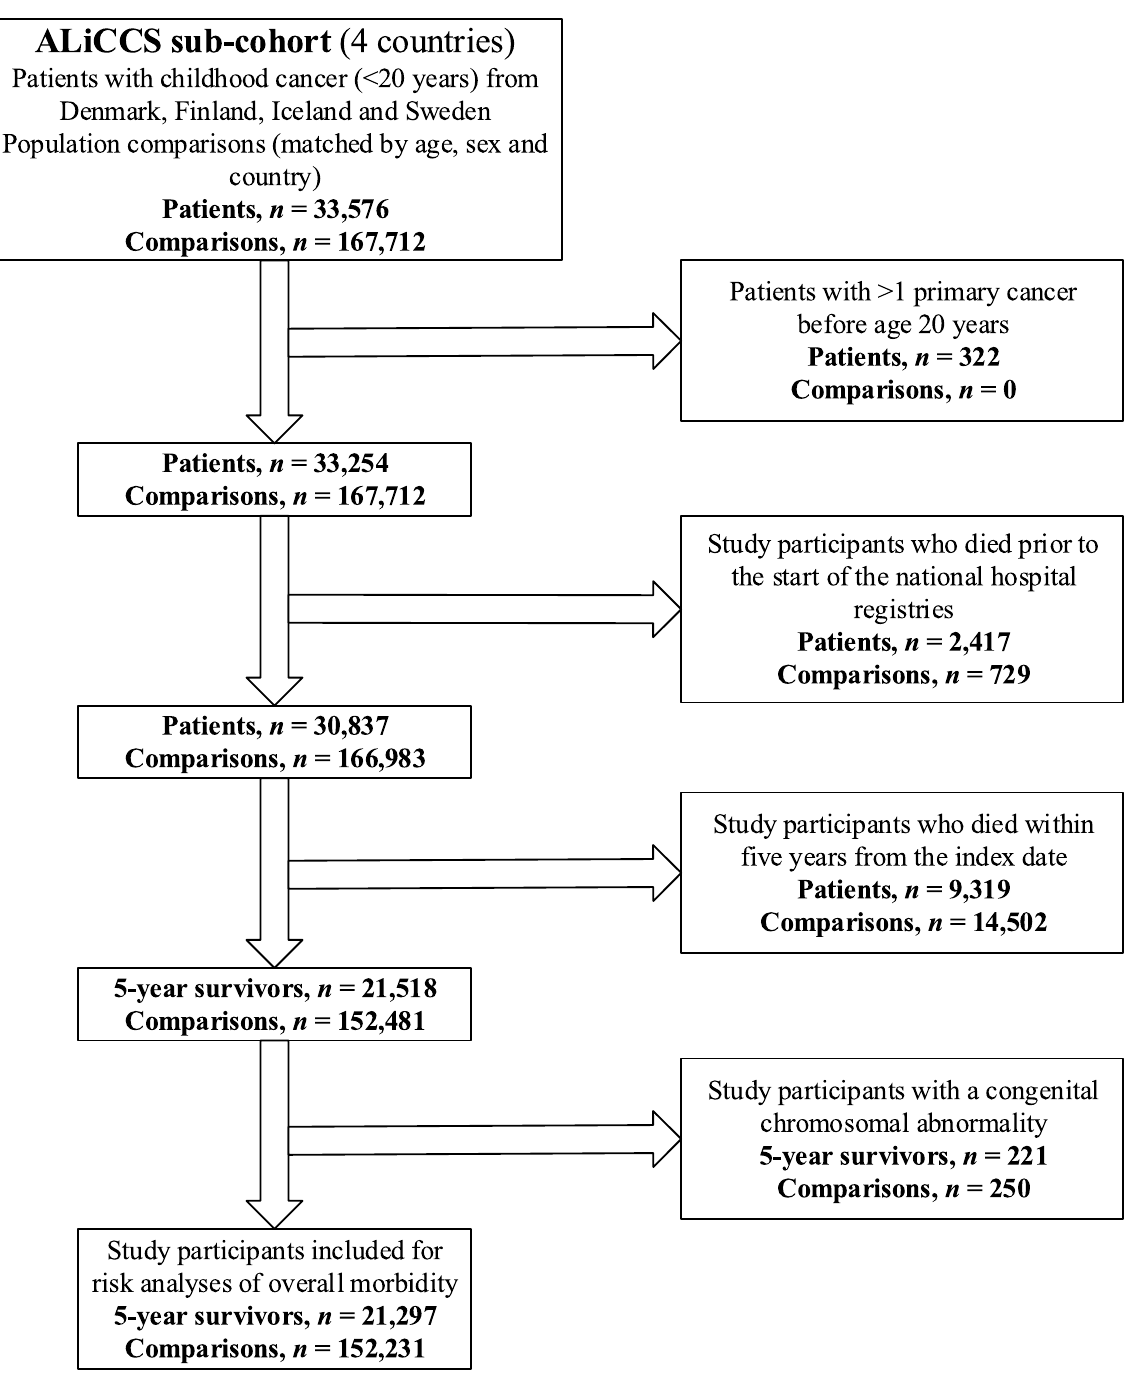
Fig 1. Flow diagram of exclusions of study participants and final study cohort size. Note: the index date is the date of cancer diagnosisand the corresponding date for populationcomparisons.